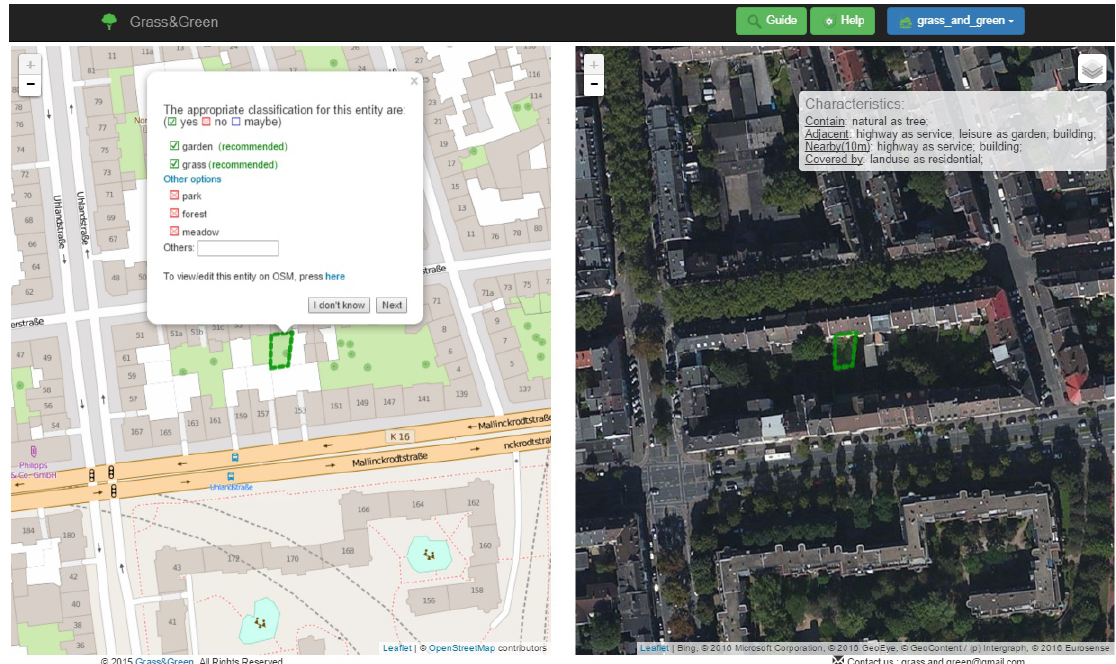
Figure 6. Validation interface for the presented